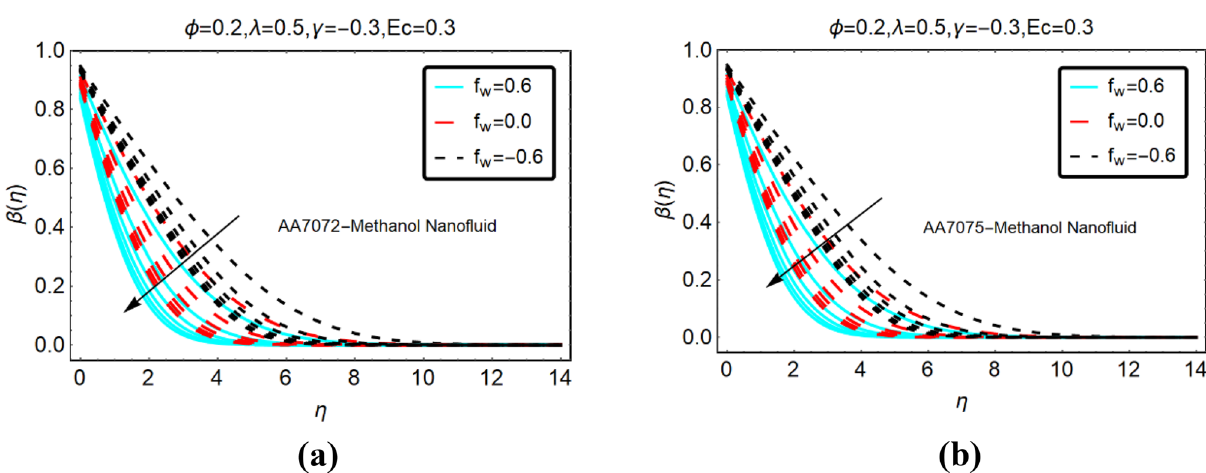
Figure 5. The effects of Rd on β(η) ( a ) AA7072-Methanol ( b ) AA7075-Methanol for heat absorption.